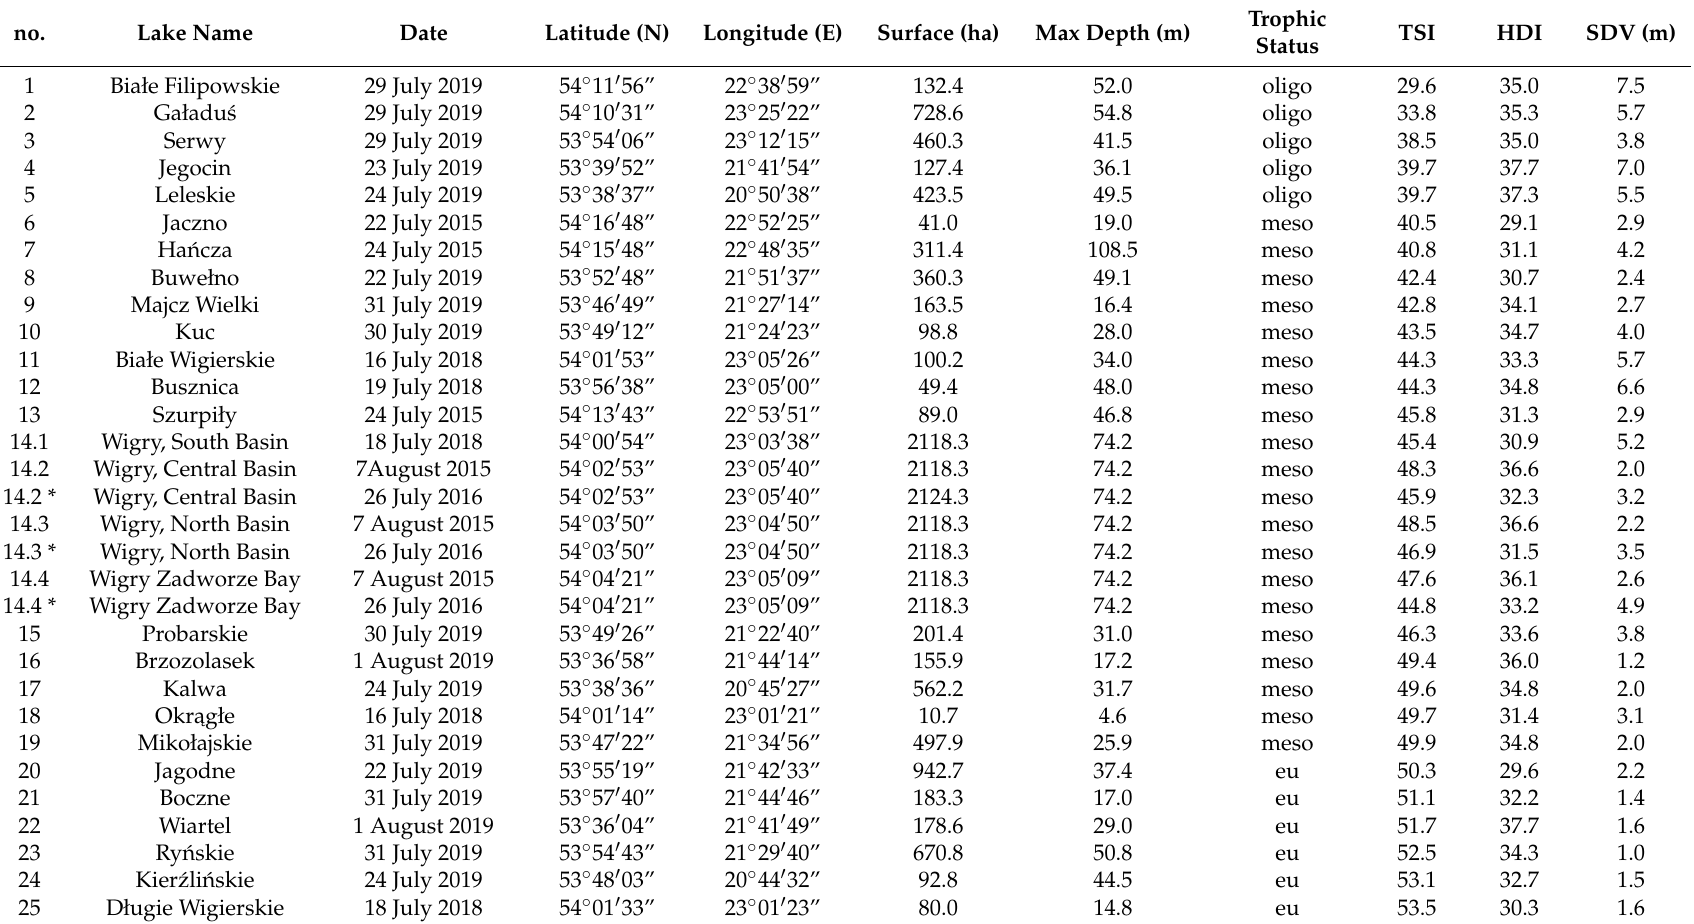
Table 1. Morphometric and trophic characteristics of the studied lakes in north-eastern Poland. TSI—Carlson trophic state index; HDI—hydrochemical dystrophy index; SDV—Secchi disc visibility; oligo—oligotrophic; meso—mesotrophic; eu—eutrophic; dy—dystrophic. The lakes which were studied twice have been marked with an asterisk (*) after the lake